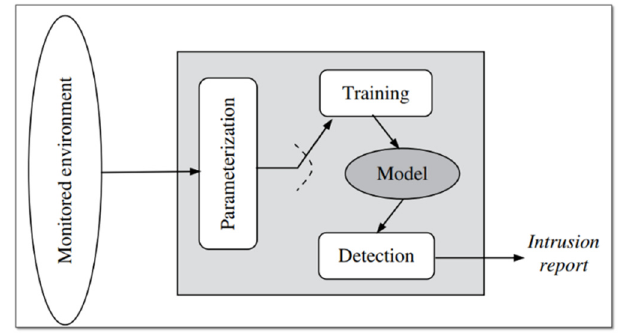
Figure 5. Generic Anomaly model of NIDS [44].